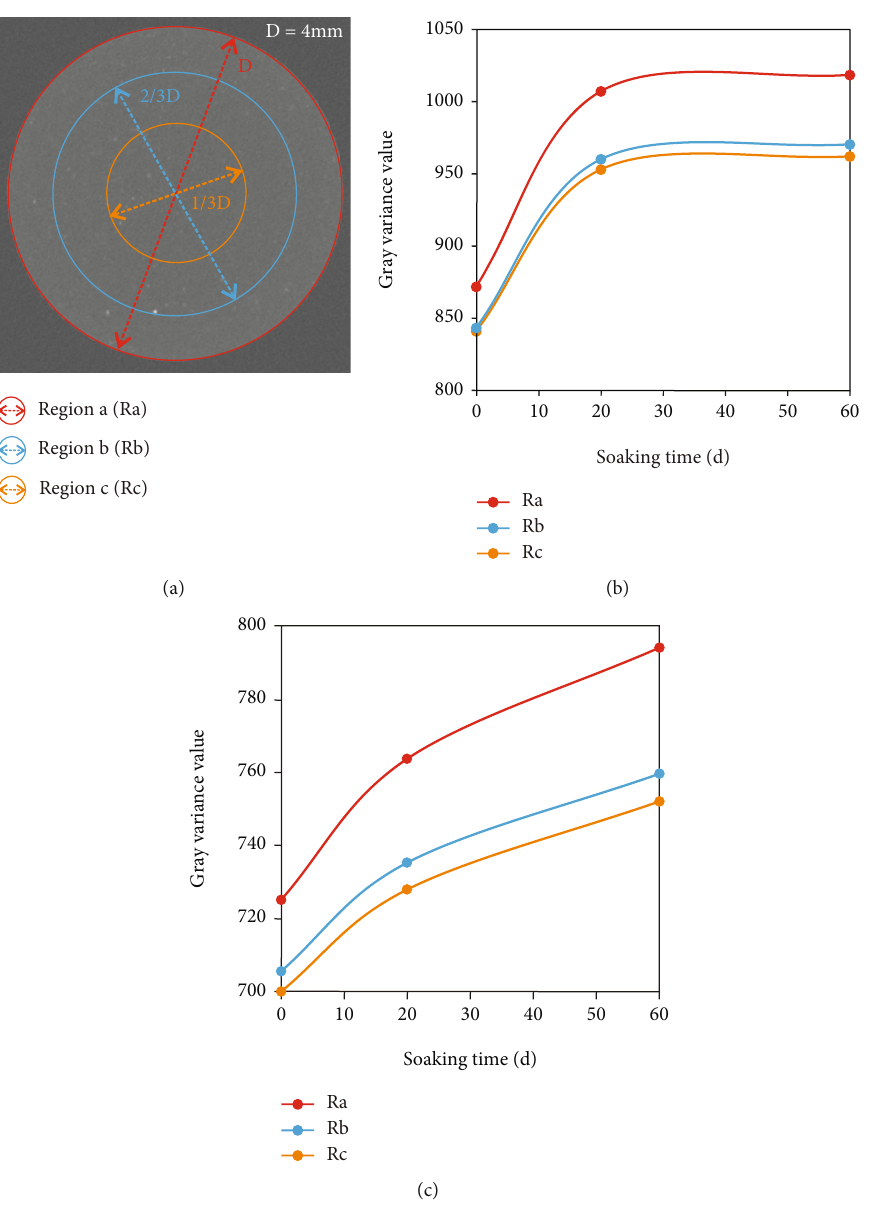
Figure 5: Diagram of statistical regions (a) and evolution curves of gray variance value in S1 (b) and S2